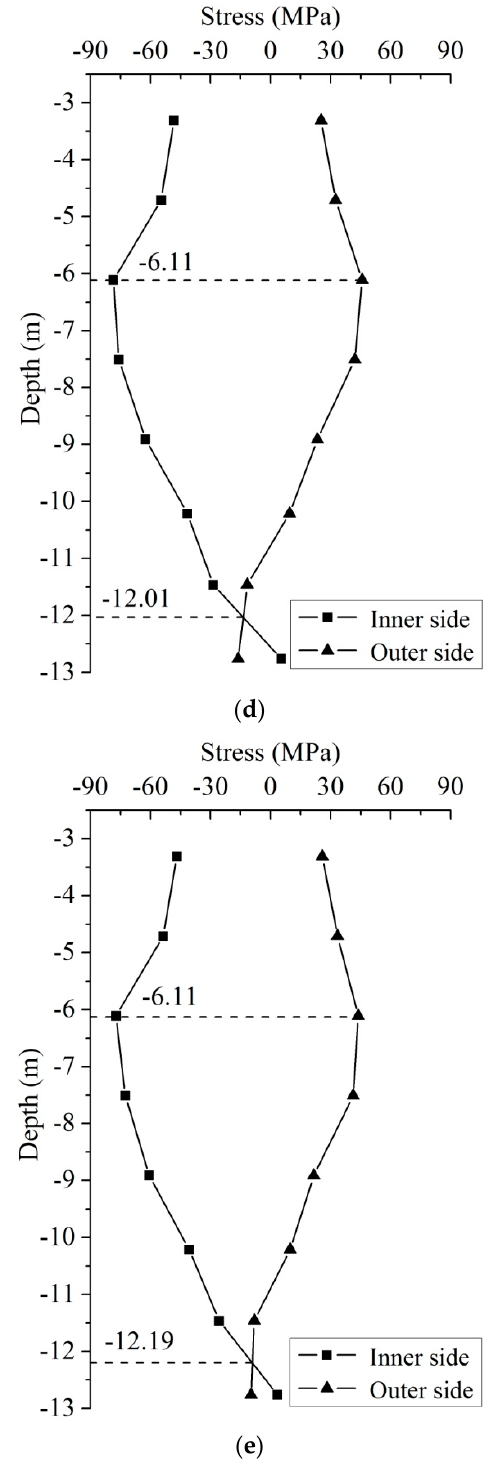
Figure 2. The stress distribution characteristics of the H-shaped steel in the SMW pile Z1 under five construction conditions. ( a ) The stress distribution of the H-shaped steel under construction condition 1; ( b ) the stress distribution of the H-shaped steel under construction condition 2; ( c ) the stress distribution of the H-shaped steel under construction condition 3; ( d ) the stress distribution of the H-shaped steel under construction condition 4; and ( e ) the stress distribution of the H-shaped steel under construction condition 5.